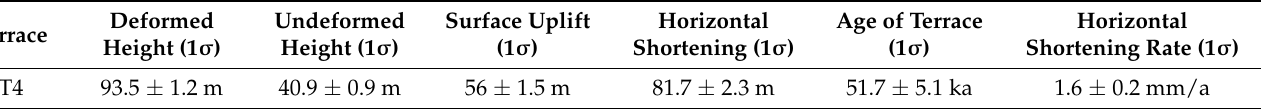
Figure 8. ( a ) Terrace deformation patterns and bedding attitudes were used to deduce the subsurface geometry and correlate the kinematic model, and the profile for T4 was used to quantify the uplift it recorded. ( b ) Kinematic model modified from Amos et al. [98], Cardozo and Brandenburg [62], and Trexler et al. [99]. Table 1. Model associated deformation estimates, age constrains, and calculated shortening rate.